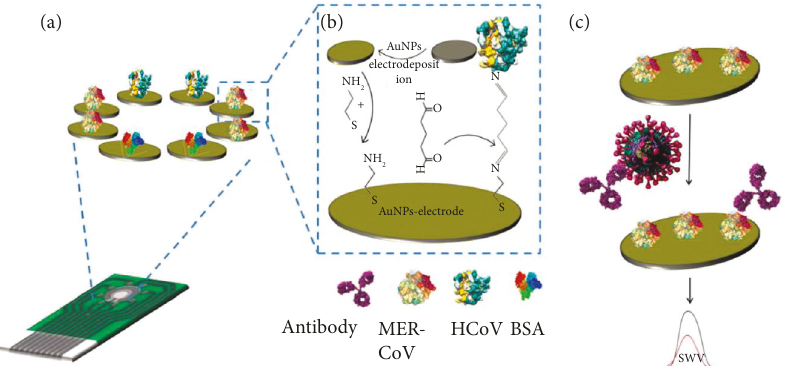
Figure 1: COV immunosensor array chip (a). The immunosensor fabrication steps (b). the detection process of the competitive immunosensor for the virus (c)